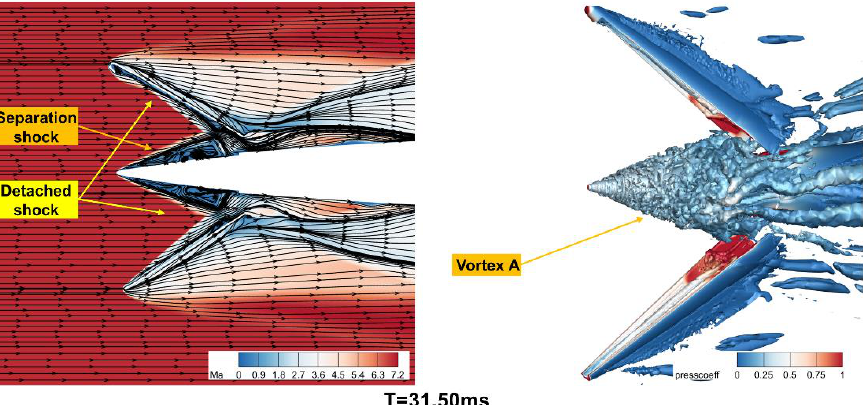
Figure 28. The contour of the streamline and Mach number ( left ), and iso-surface of Q-criterion ( right ) at Time = 31.50 ms.